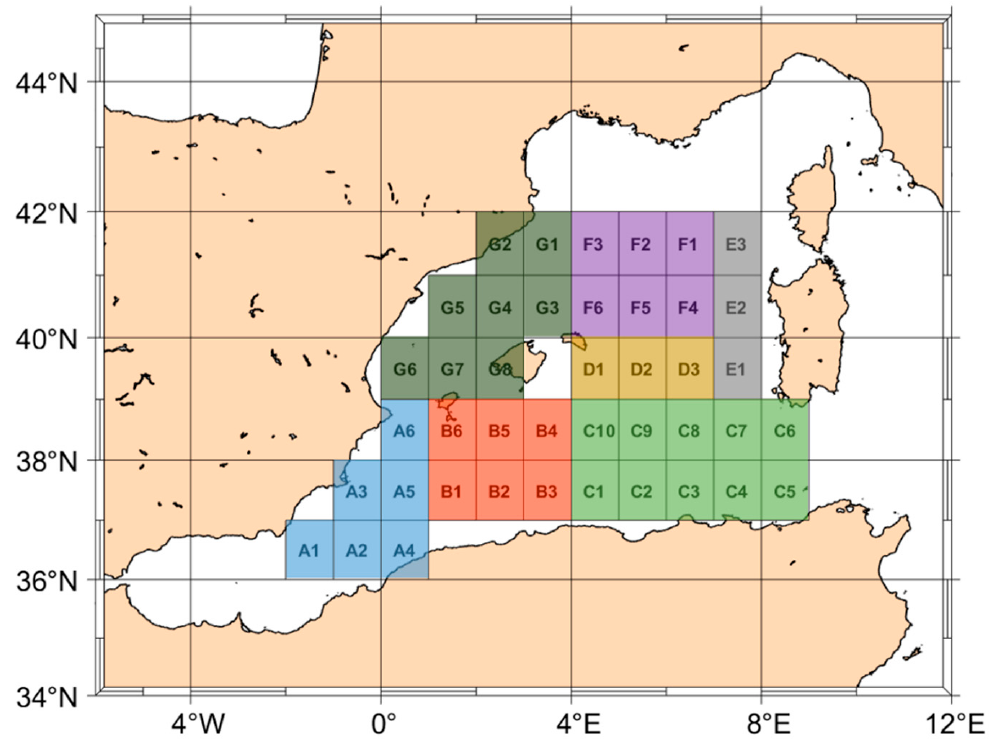
Figure 4. The division of the Western Mediterranean basin into 7 homogeneous sectors and the regular 1 ◦ × 1 ◦ box grid used for the connectivity analysis. Color scale highlights the different sectors. To this end, the WMED study area has been divided into 7 sectors (colored areas in Figure 4) characterized by similar dynamics and water properties, based on existent literature. Then each sector has been split into a variable number (3 to 12) of boxes of 1 ◦ × 1 ◦ , used for the connectivity analysis (Figure 4). The dimension of the boxes was defined to be larger than the expected dimension of mesoscale eddies in the area and to allow a significant drifter data density in each box. For each dataset, we analyze and discuss the number of drifters/AEs connecting the different boxes. This variable is defined as the number of drifters/eddies moving from a specific i-th source box toward a j-th specific destination